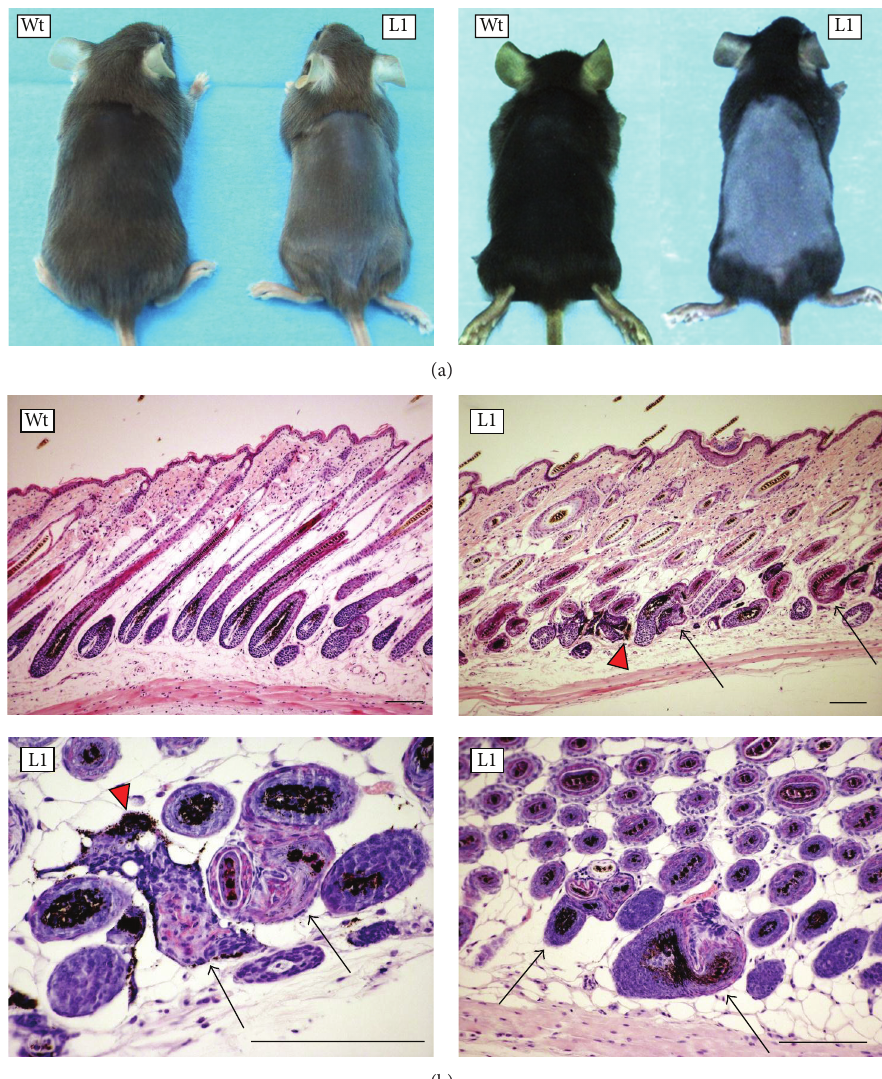
Figure 5: Most H1-IKK1-siRNA transgenic mice showed delayed hair follicle regrowth and hair follicle anomalies after depilation. (a) Slight (left) and severe (right) delay in the regrowth of hair follicles 11 days after depilation in transgenic mice. (b) Hematoxylin and eosin staining of skin histological sections. Morphological alterations in hair follicles of transgenic mice (black arrows) and dermal melanin deposition (red arrowheads) are shown. Bar: 80 𝜇